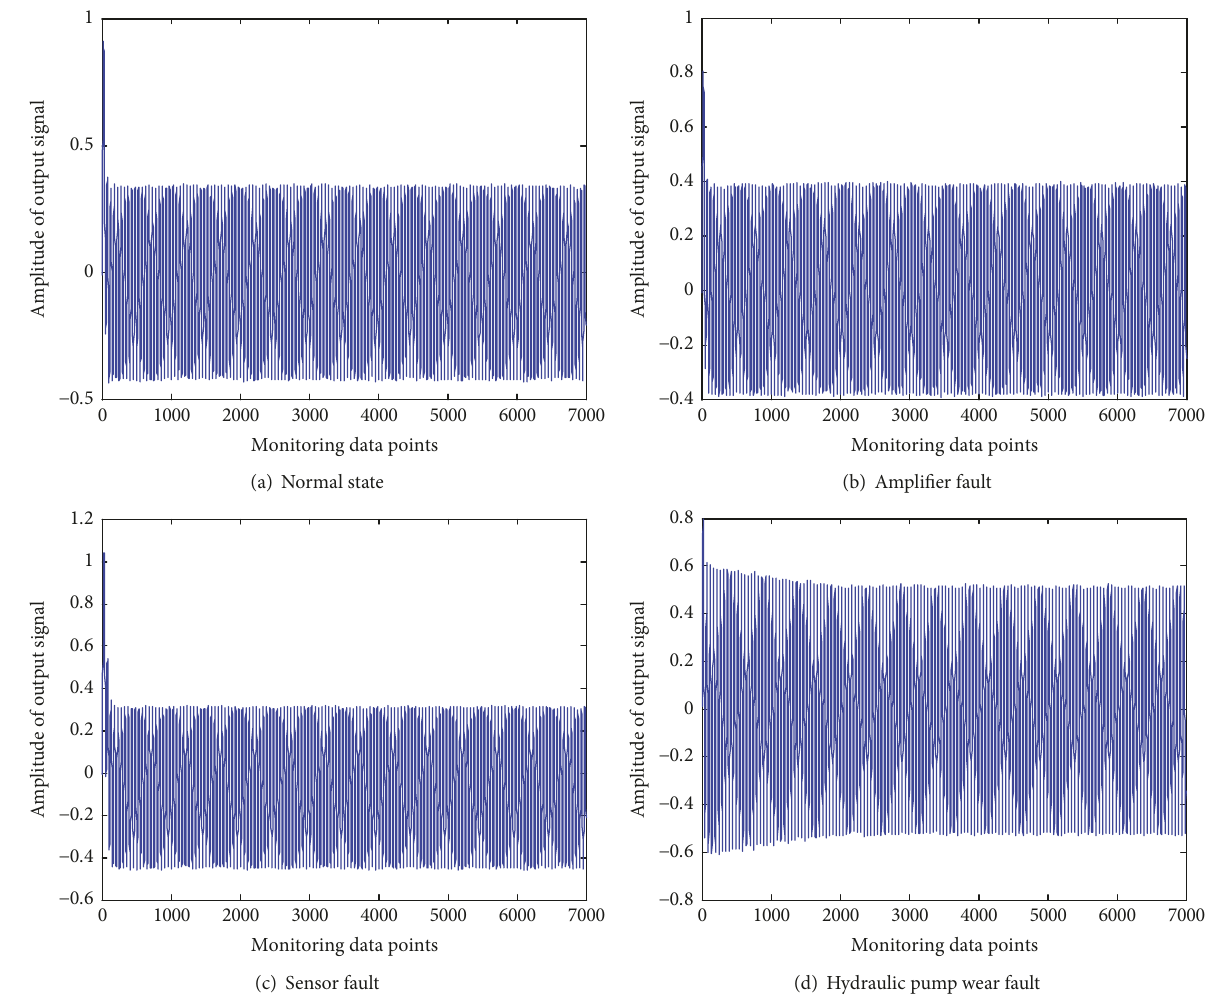
Figure 4: Original output signals of the hydraulic servo